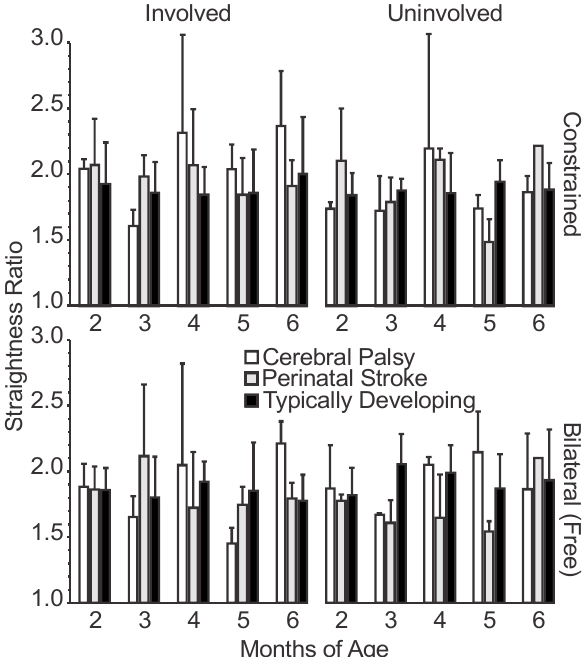
Figure 4. Mean straightness ratio by age, side, and condition. For typically developing infants, the left arm is plotted alongside the involved limb and the right arm is plotted alongside the uninvolved limb. Error bars show 1 standard deviation.